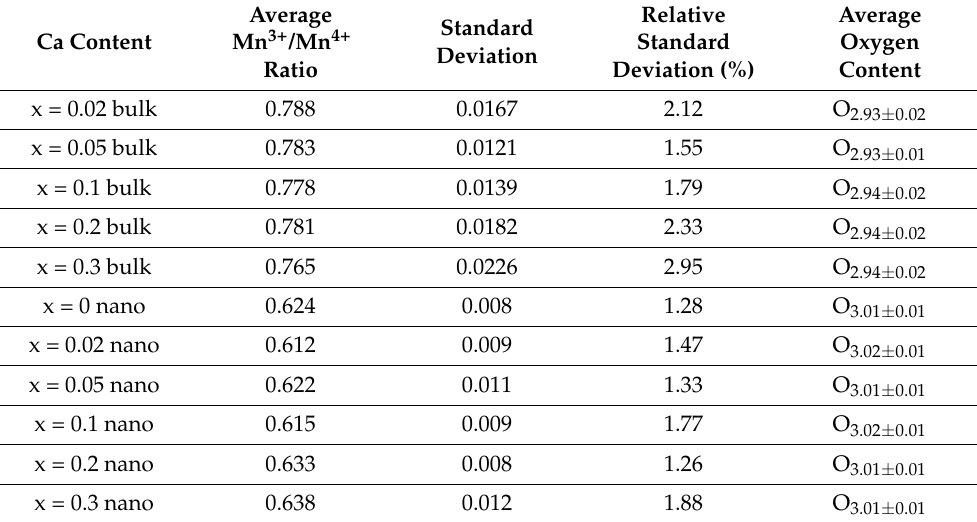
Table 3. Average oxygen content calculated using iodometry for bulk and nanocrystalline